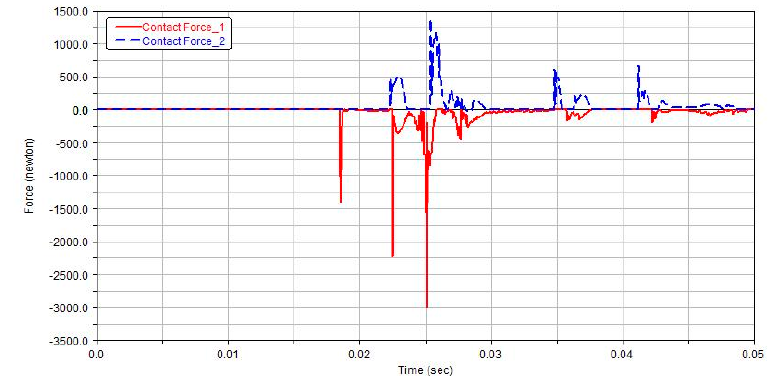
Figure 8. The contact force of a typical rigid collision system. The red line indicates the contact force between the first set of pin and hole while the blue line indicates the contact force between the second group.